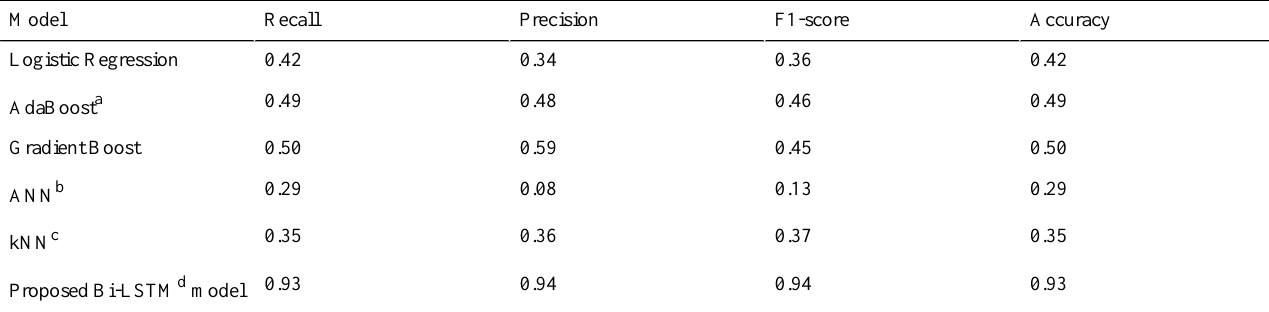
Table 7. Comparative results of deep learning with traditional machine-learning models.